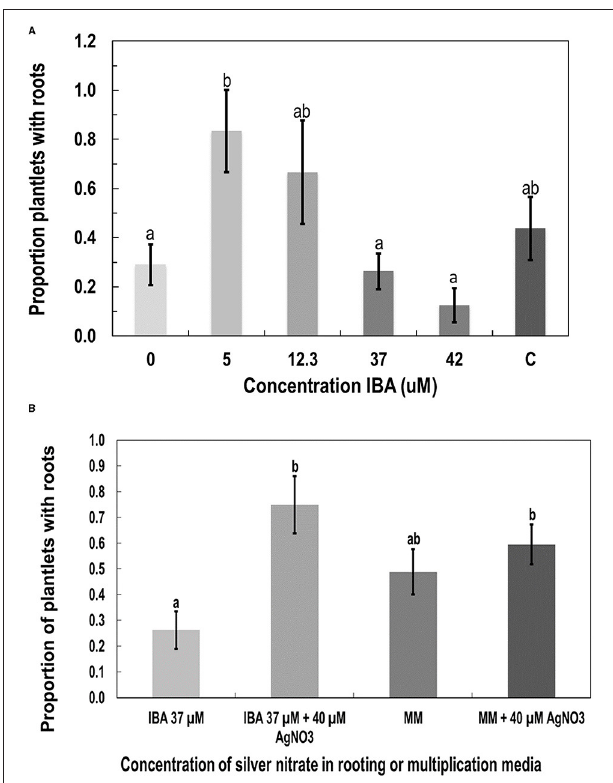
FIGURE 7 | The effect of additives to the MS salts medium on root development in plantlets of genotype MBD derived from nodal stem segments after 4 weeks of growth. Additives were (A) indole-3-butyric acid IBA, (B) silver nitrate (AgNO 3 ), compared with MM as a control. Statistical analysis was performed by Tukey’s HSD test with significance at p < 0.05. Bars followed by different letters indicate significant